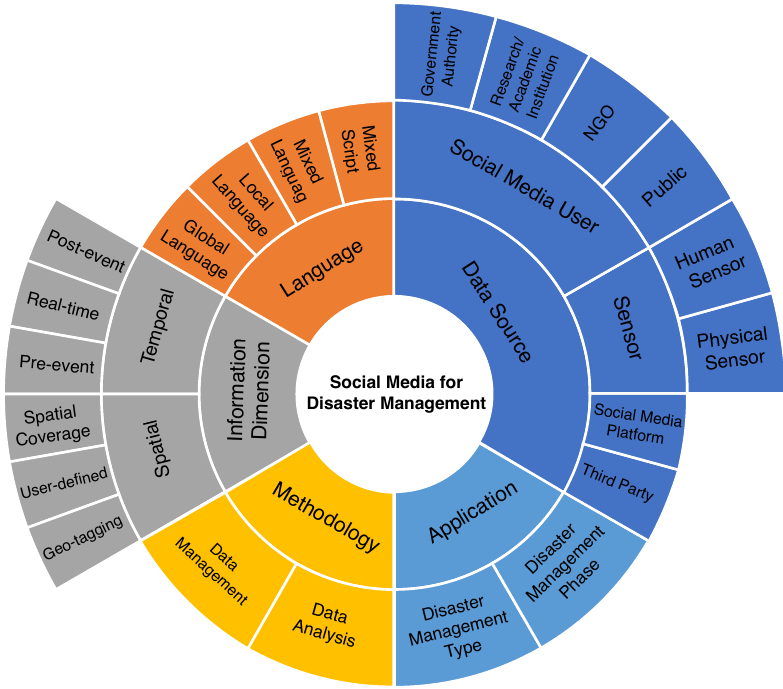
Figure 1. Taxonomy of social media data management. The taxonomy elements are described